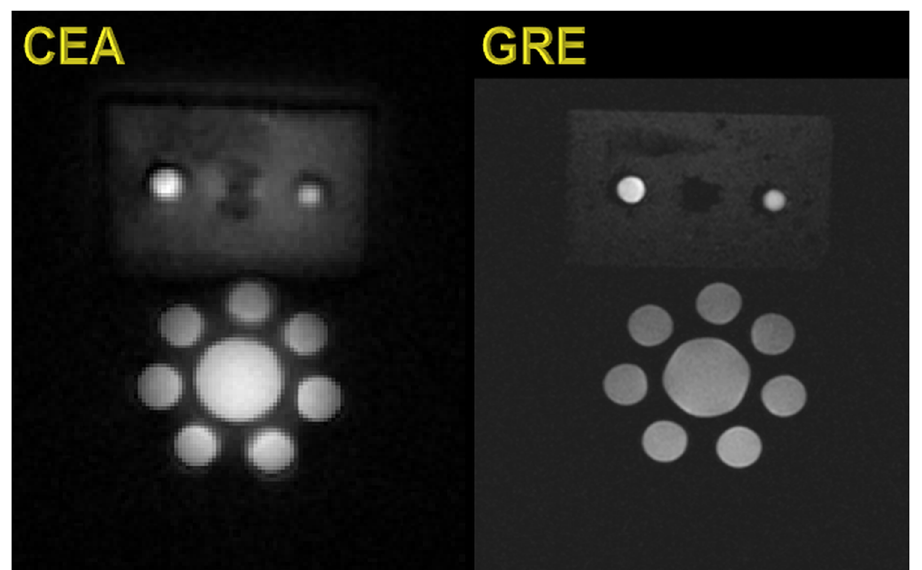
Figure 6. Coronal slice from the 3D CEA MR image of the tube and rubber phantoms (left), and GRE image as the structural reference (right).